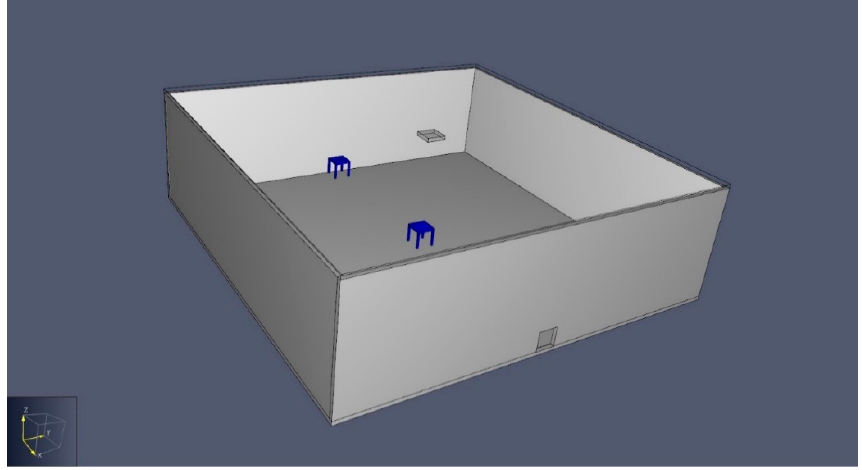
Figure 1. An industrial building where two points of emergency release: blue tables (located on a ground), and two ventilation hoods: dark grey squares (one on a ceiling and one on a wall) were